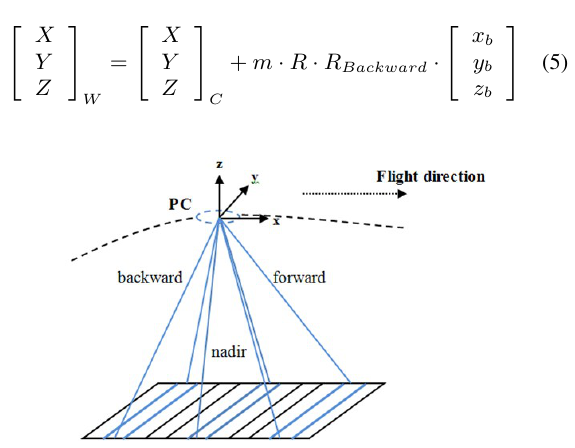
Figure 3: Three CCD linear array sensors (forward, nadir, back- ward